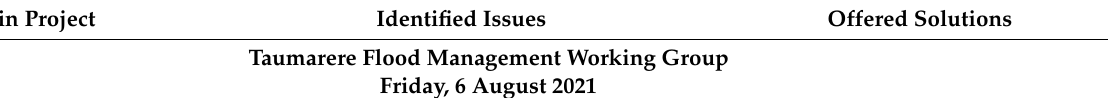
Table A2. Example of flood meeting in three catchments 2021 (Source: